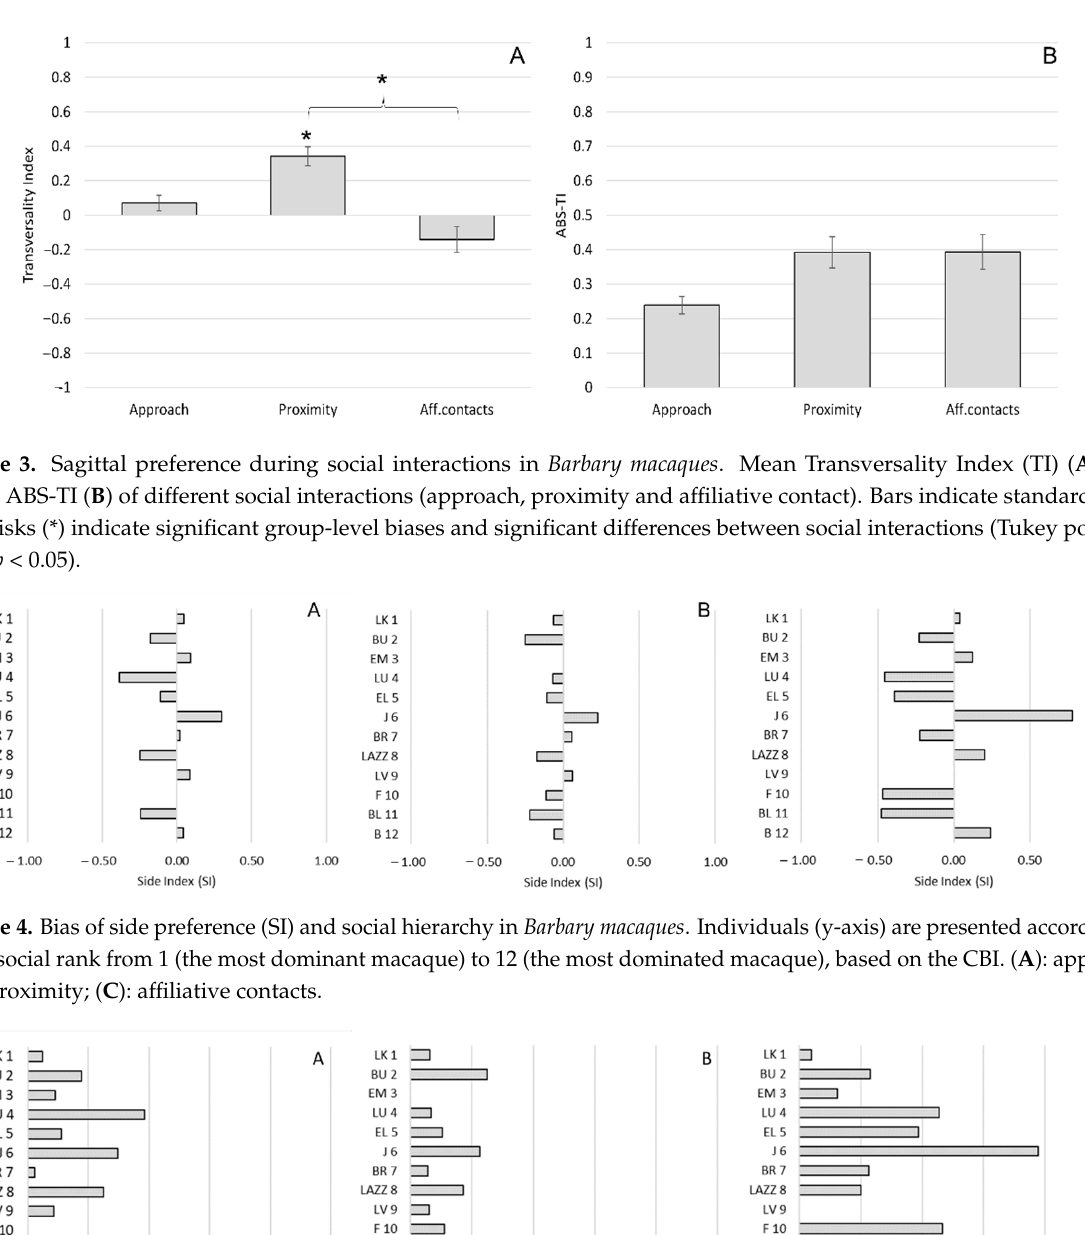
6 of 11 Figure 2. Side preference during social interactions in Barbary macaques . Mean Side Index (SI) ( A ) and mean ABS-SI ( B ) of different social interactions (approach, proximity and affiliative contact). Bars indicate standard error. Asterisks (*) indicate significant differences between social interactions (Tukey post hoc test: p < 0.05). 3.2. Sagittal Preferences during Social Interactions At the individual level, we found a significant bias in the TI for 1 out of 12 macaques (8%) that was approached significantly more on the rear than in front (Table 1). For prox- imity, we found that 3 out of 12 macaques (25%) had a significant bias in the TI and were kept by near conspecifics on the front rather than on the rear (Table 1). For affiliative con- tacts, we found that two out of nine macaques (22%) had a significant bias in the TI: one received significantly more affiliative contacts on the front, one on the rear side. The mean ± SE of the TI was 0.07 ± 0.09 for approach, 0.34 ± 0.11 for proximity and − 0.14 ± 0.15 for affiliative contacts (Figure 3A). The mean ± SE of the ABS-TI was 0.24 ± 0.05 for approach, 0.39 ± 0.09 for proximity and 0.39 ± 0.10 for affiliative contacts (Figure 3B). The one-sample t -test revealed a significant group-level bias for proximity, with ma- caques being kept in front by conspecifics rather than on the rear ( t (11) = 3.233; p = 0.008).